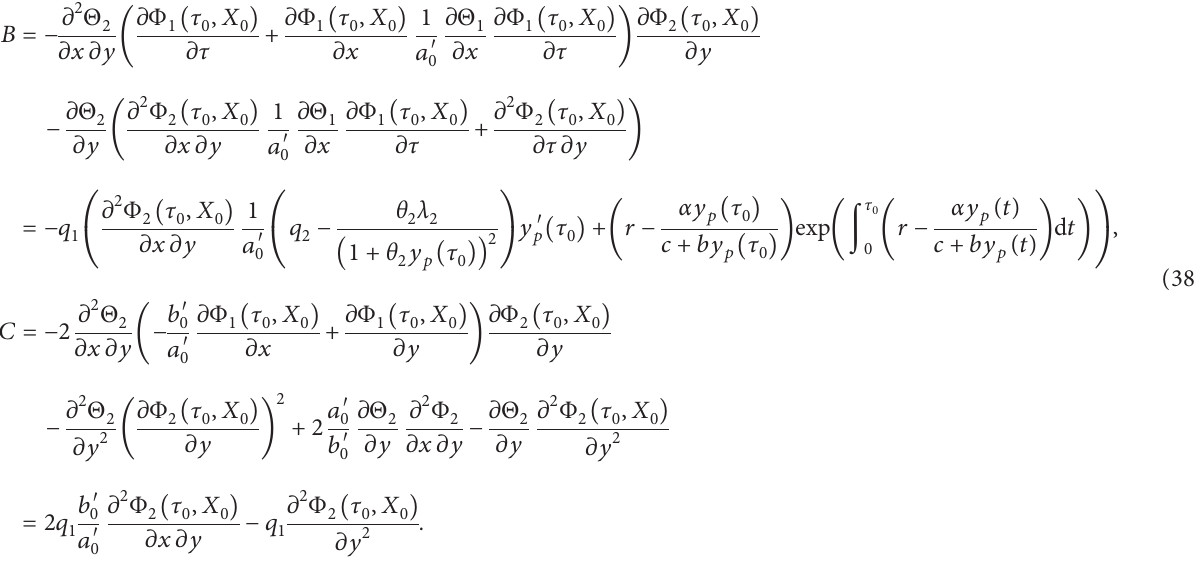
. Parameter values are as follows: r � 2 . 18 , K � 5 . 5 , c � 1 . 15 ,b � 0 . 01 , α � 2 � 1 . 2 , θ � 2 ,q � 0 . 98 , λ � 1 . 4 , λ � 2 . 2 , and T � 16 . 1 2 2 1 2